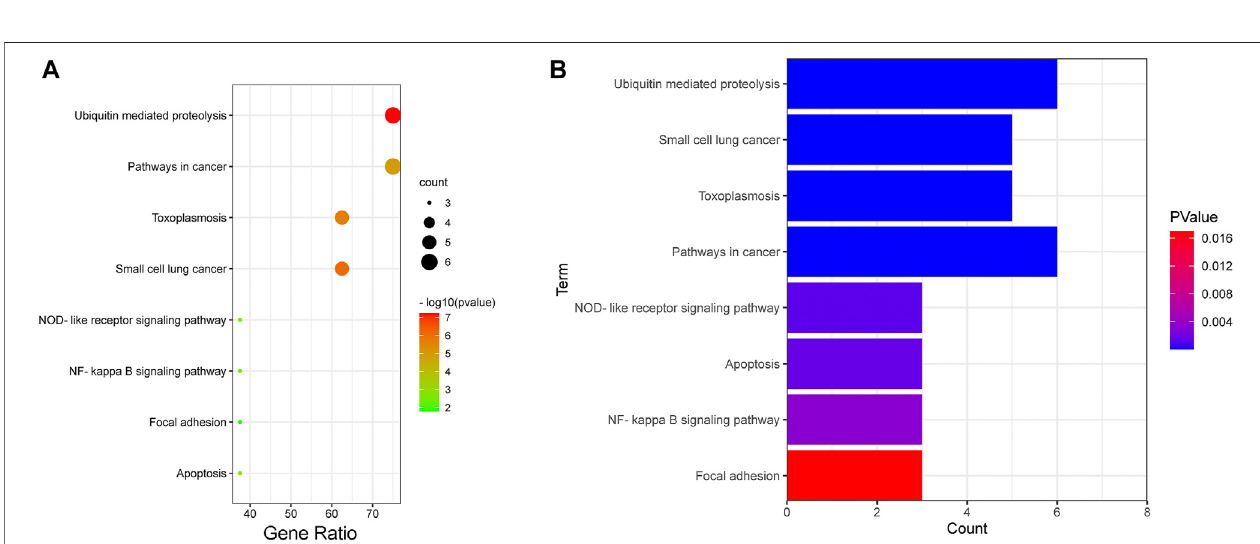
FIGURE 7 | KEGG analysis of IAPs. (A) Enrichment dot bubble diagram. (B) Enrichment histogram. KEGG: Kyoto Encyclopedia of Genes and Genomes.